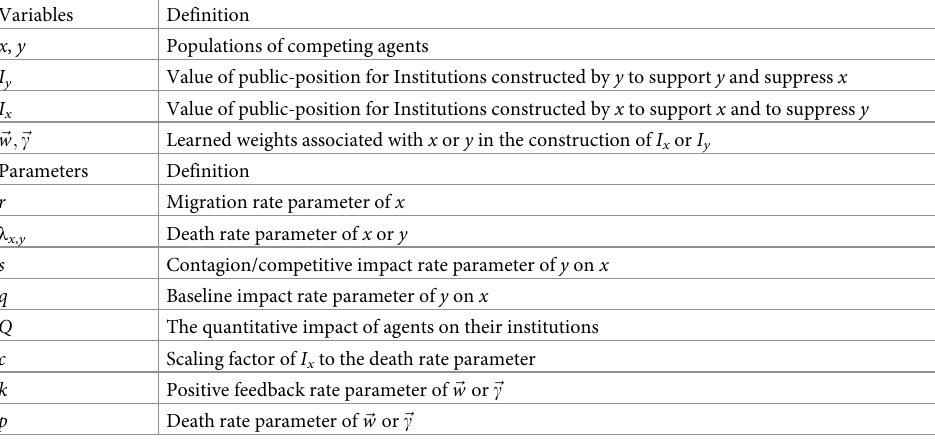
Table 1. Table of variables and parameters employed in institution construction model.